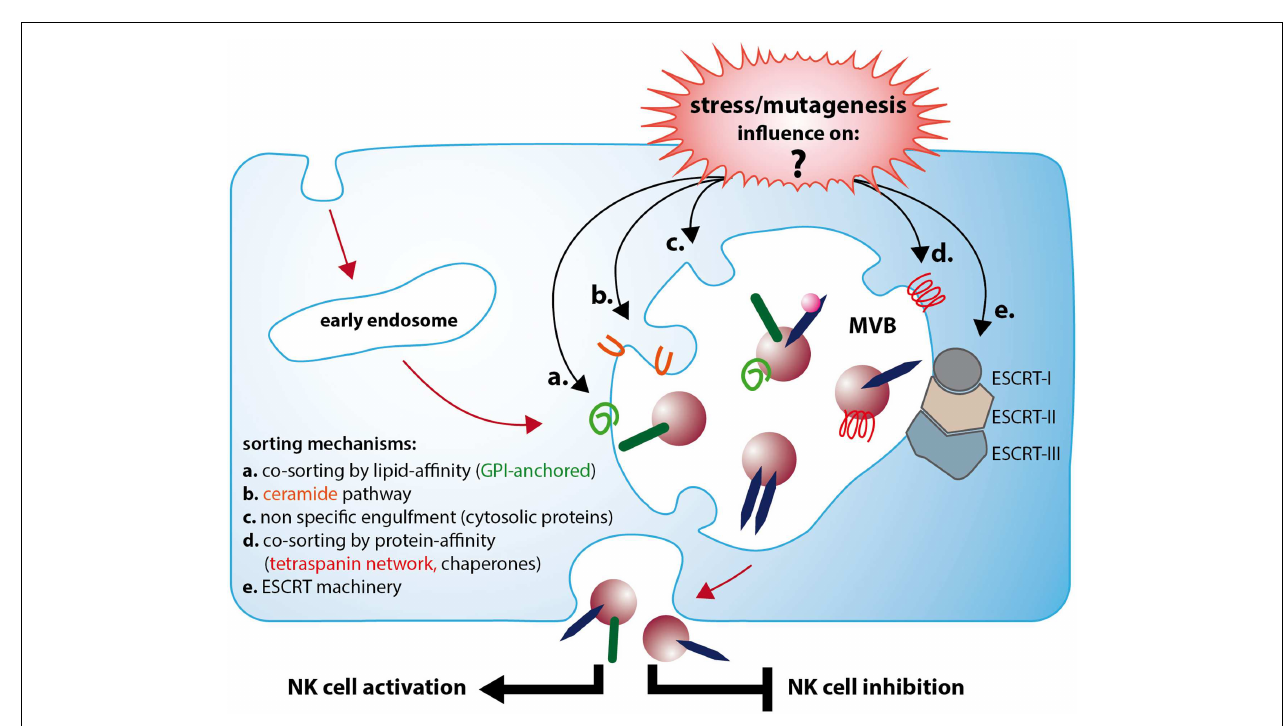
are described, the mechanisms leading to the respective exosome formation are still poorly understood. A major question remaining to be answered is how stress and mutagenesis affect the different sorting mechanisms responsible for the genesis of immune-activating or -suppressive vesicles. As soon as the determining pathways and their regulation are comprehensively explored, the exosome cargo will become more predictable and allow the development of new, astute strategies to employ exosomes as therapeutic